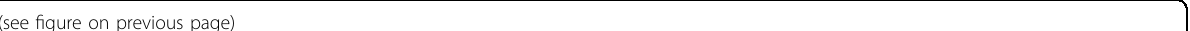
HCl (pH 7.4), 50% glycerol, and cOmplete protease inhibitor cocktail (Roche Applied Science). Each sample was heated in 6× loading buffer at 95 °C for 5 min, resolved by sodium dodecyl sulfate-polyacrylamide gel electrophoresis, and transferred to polyvinylidene fl uoride membranes (Milli- pore). Membranes were treated with blocking solution (1% milk in 1× phosphate-buffered saline with 0.1% Tween 20 ® ) for 30 min and incubated with rabbit anti-RGMa (1:100, 28045, Immuno-Biological Laboratories) and rabbit anti- β -actin (1:1000, 4970; Cell Signaling Technology) overnight